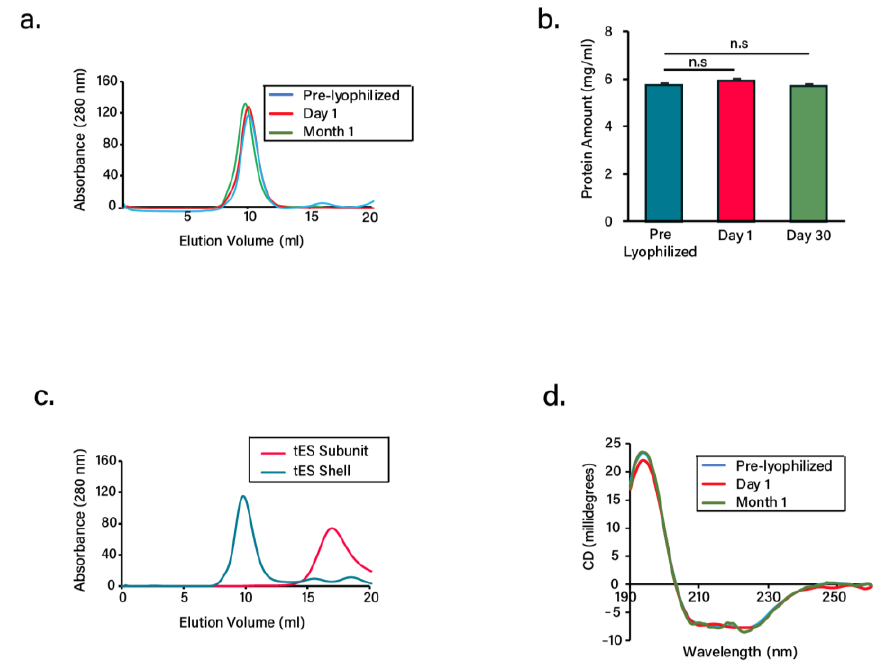
Figure 2. Characterization of freeze-dried tES. ( a ) Size-exclusion chromatogram of freeze-dried tES at pH 8.0 after storage at days 1 and 30 at room temperature. Pre-lyophilized samples were considered as control. ( b ) Comparison of concentrations of freeze-dried tES after storage at days 1 and 30. Pre-lyophilized samples were considered as control. ( c ) Size-exclusion chromatogram of the freeze-dried tES subunits after storage at day 30. The subunits were either reconstituted in 50 mM Tris-HCl pH 8.0 for their shell assembly or 50 mM sodium acetate buffer pH 5.8. ( d ) CD spectra of freeze-dried tES after storage at days 1 and 30 at room temperature. Compared to pre-lyophilized samples, tES exhibited double minima at 210 nm and 225 nm typical of α -helical structure (n = 3, mean ± SD).